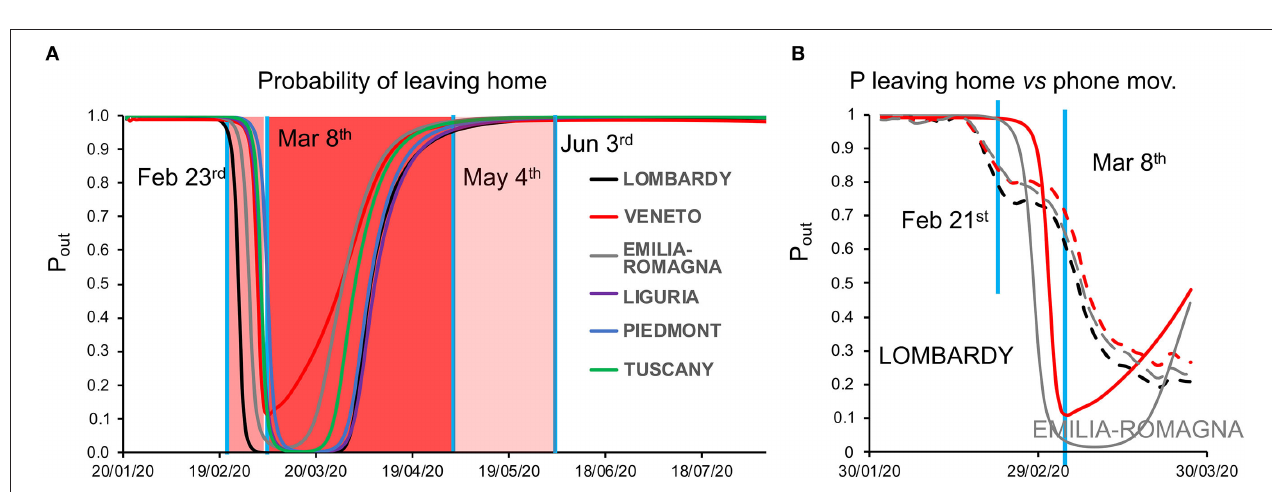
FIGURE 2 | (A) Dynamics of the probability of leaving home. The plot shows the time course of the probability of leaving home inferred by model inversion (colored lines) in the temporal window from January 22 to August 22, 2021. During this period, the Italian government imposed a lockdown with different degrees of severity from February 23 (soft lockdown: country-wide closing of schools, universities, and all non-essential industrial and commercial activities; limiting the activities of public offices) to March 8 (tight lockdown: prohibition of any kind of mobility, apart from specific health or professional needs). May 4 is the date where the tight lockdown was relaxed and people were allowed to freely move within their region, while on June 3, people were allowed to freely move within the whole country. Vertical blue lines indicate the dates of lockdown, whereas the shaded red and pink areas represent the lockdown time windows. Note the peculiar behavior of Veneto (red line), showing a lesser reduction in the probability of leaving home, indicating a reduced adherence to the lockdown orders. (B) Dynamics of the probability of leaving home, compared with cell phone movements. The graph shows the trajectory of the probability of leaving home inferred by the model (solid lines) and the monitored cell phone movements (dashed lines) for the three most hit regions (Lombardy, Veneto, and Emilia-Romagna) in the period from February 21 to March 27.